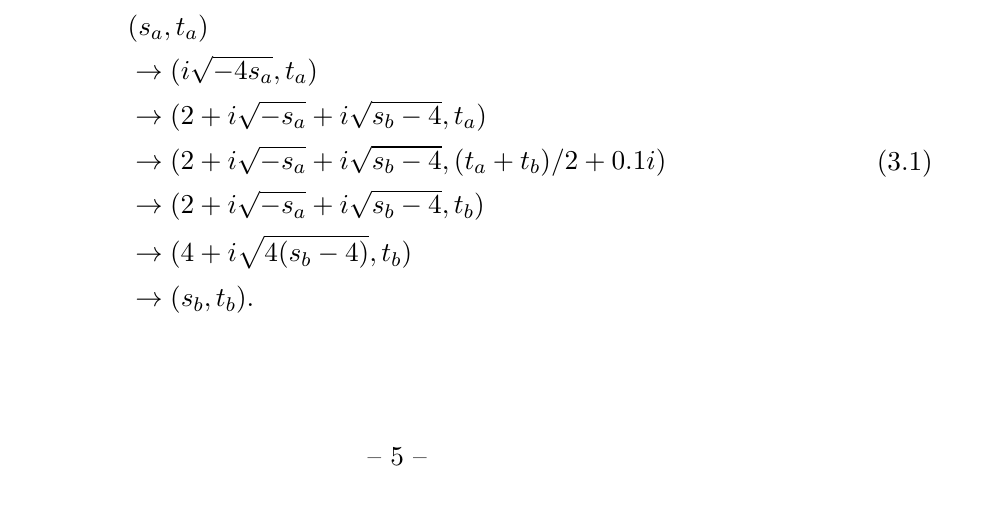
Figure 1. The three four-point two-loop integral families and I sub incoming and p 3 ; p 4 are outgoing. Thin lines represent massless particle, while thick lines are massive